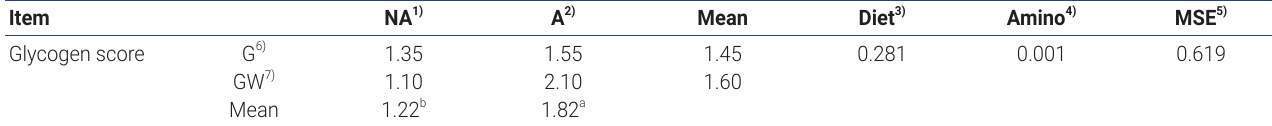
Table 5. Hepatic glycogen storage in piglets fed diets supplemented with L-glutamine + L-glutamic acid, containing or not whey